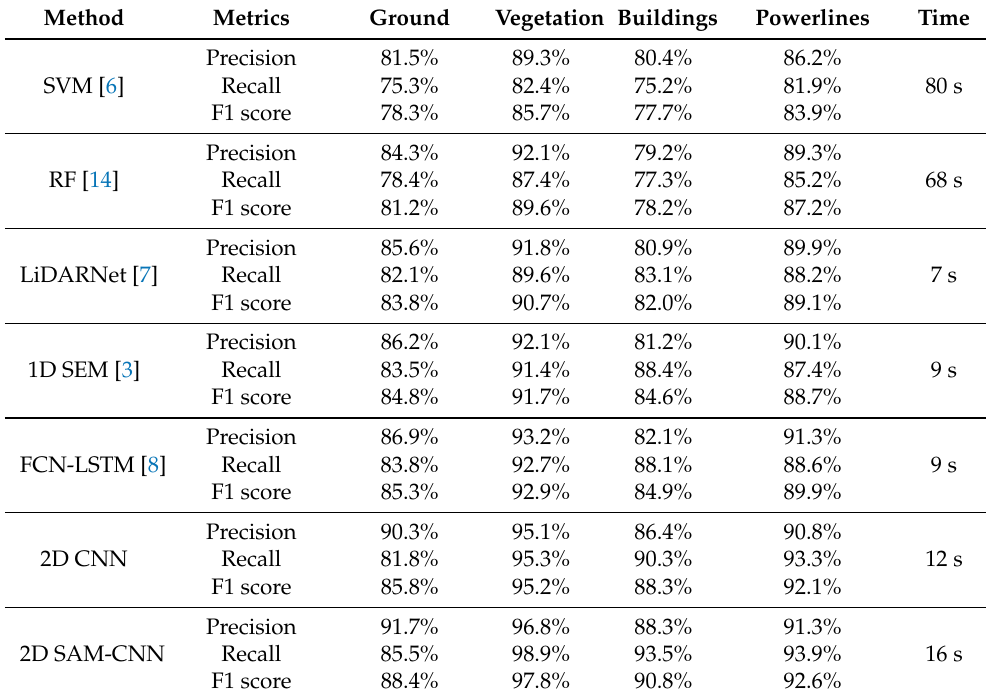
Table 3. Comparison of different methods of urban data classification.